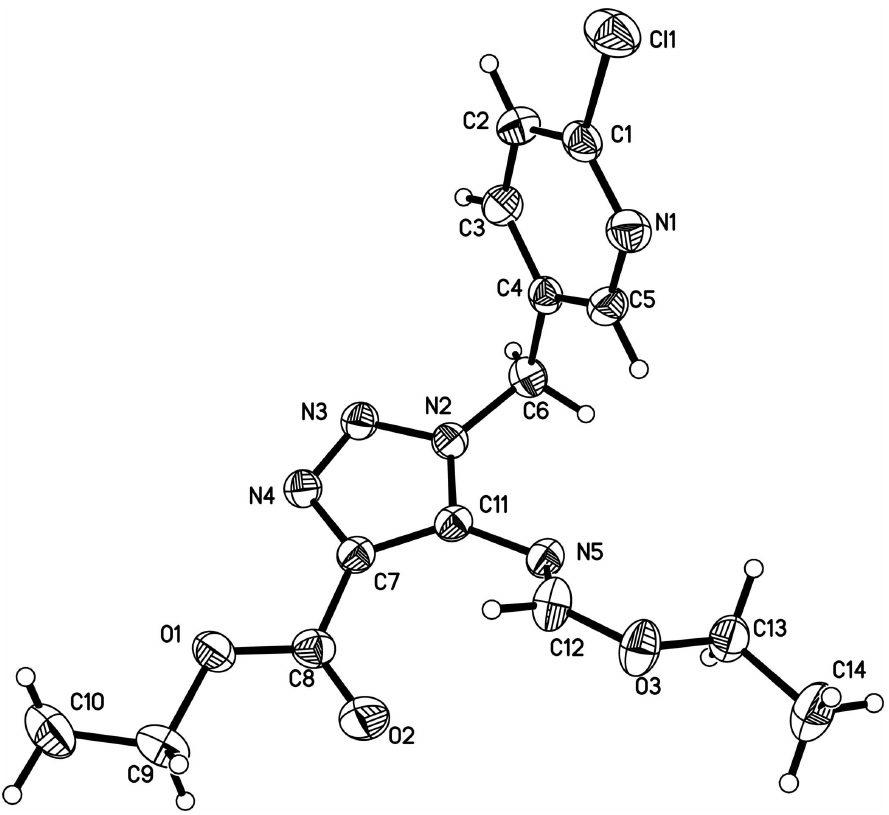
Figure 1 View of the molecular structure of (I), showing the atom labelling scheme and with displacement ellipsoids drawn at the 50% probability level.